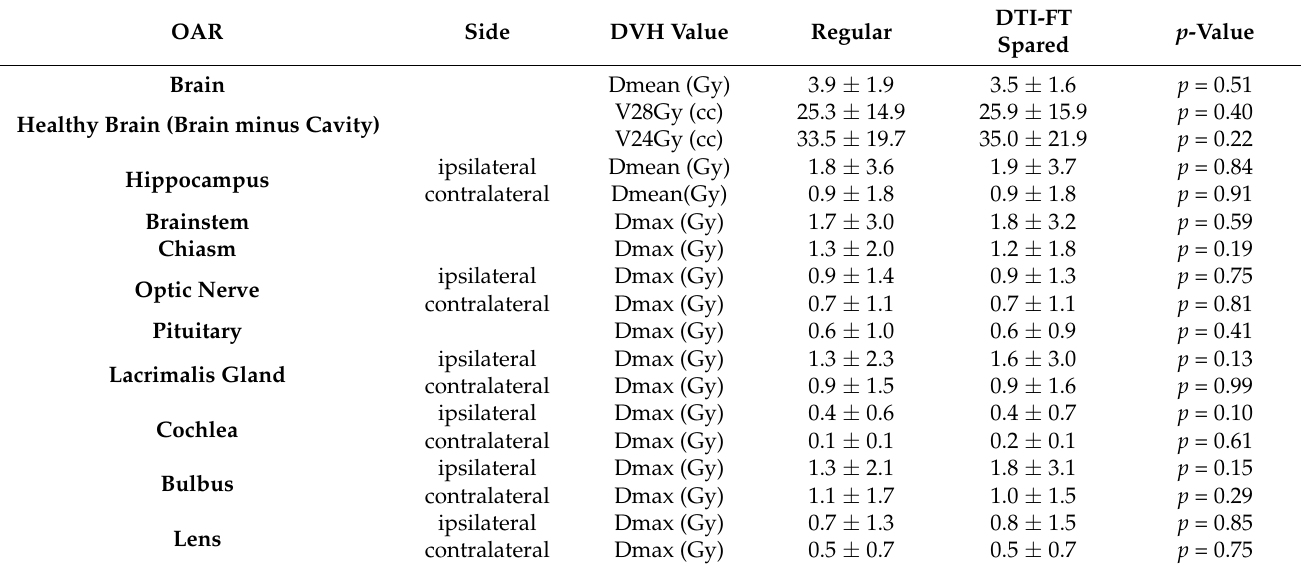
Table 4. Dose exhibition of brain and organs at risk. In comparison there were some minor changes but after recalculation dose limits were kept